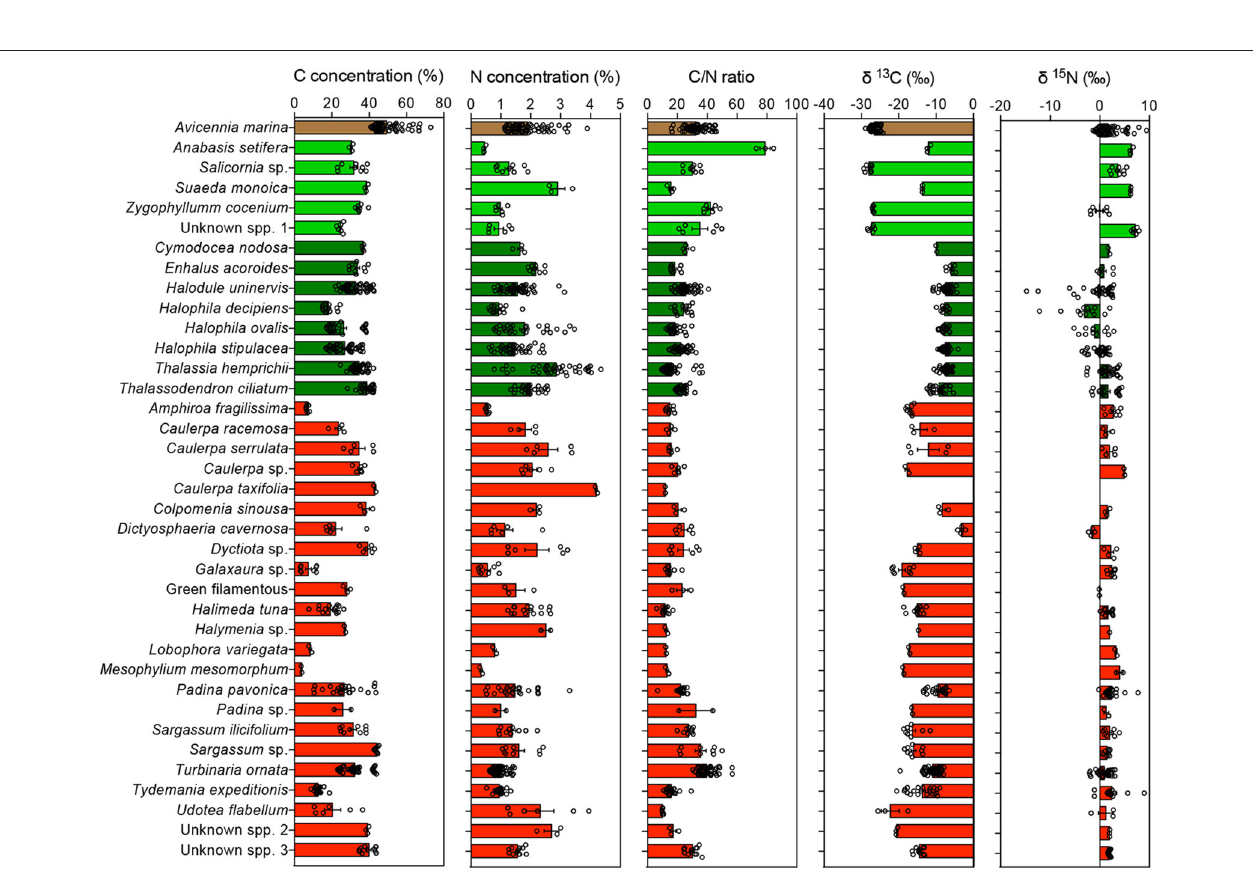
FIGURE 6 | Mean ± SE of the concentration of carbon (C), the concentration of nitrogen (N), the C/N ratio, the carbon ( δ 13 C), and nitrogen ( δ 15 N) isotopic composition measured in the blades of the different species of primary producers, color-coded by taxa. Mangroves, halophytes, seagrasses, and macroalgae are indicated in brown, light green, dark green, and red, respectively. Empty dots indicate individual measurements for each species and location.